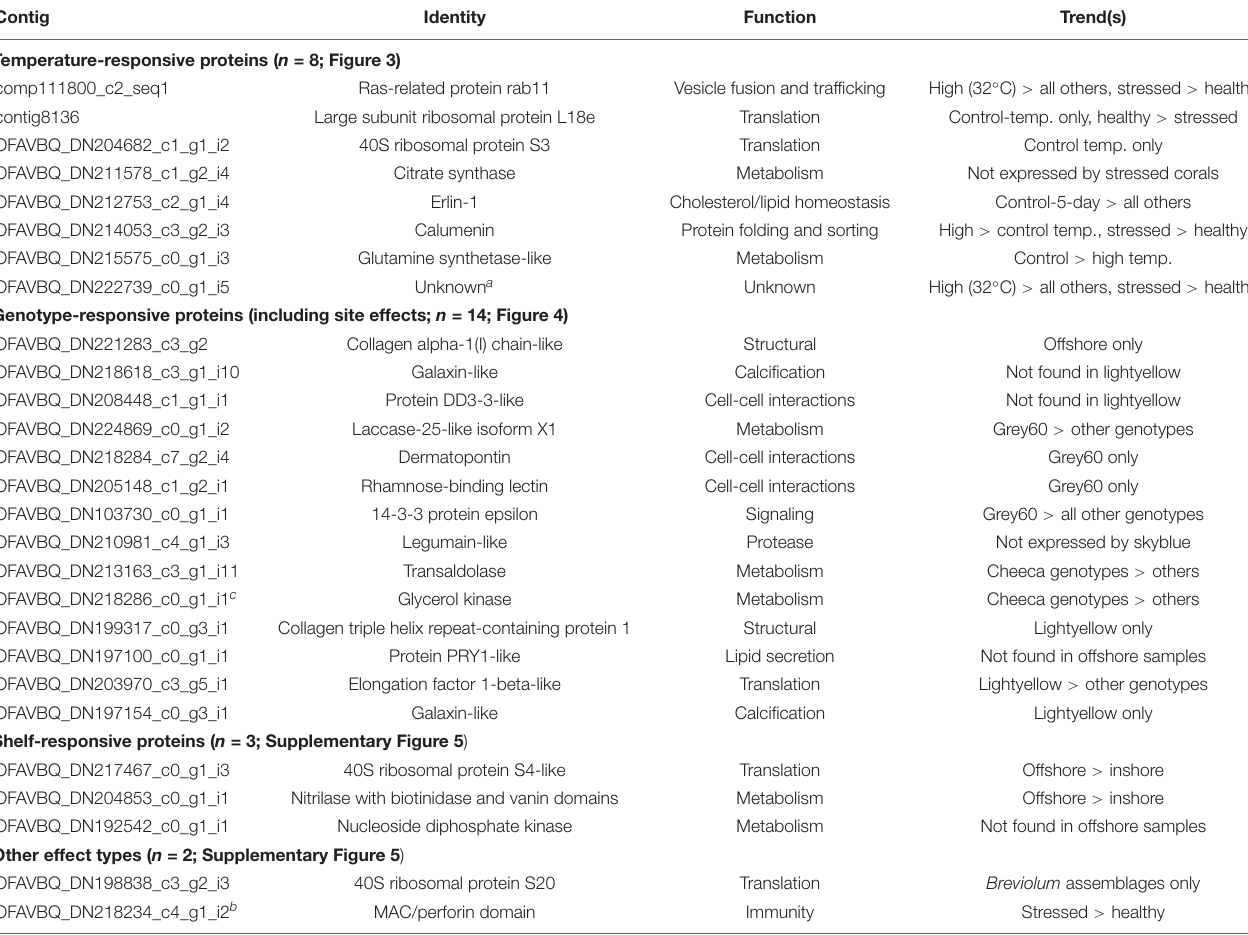
TABLE 3 | Host coral differentially concentrated proteins (DCPs). Contig